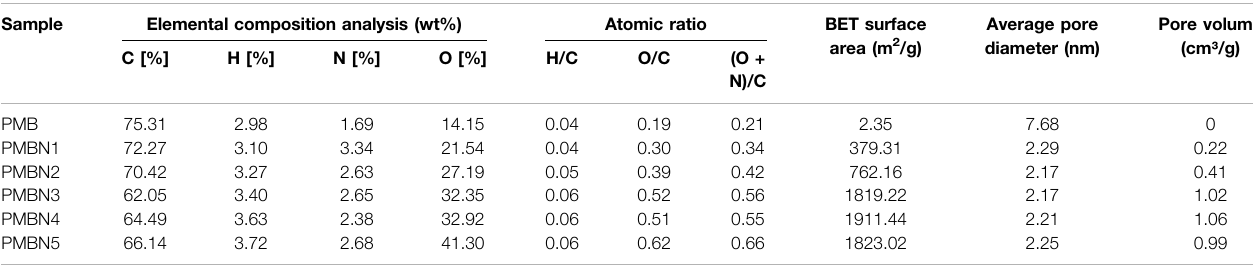
TABLE 1 | The results of elemental analysis and main structural parameters of unmodi fi ed biochar and modi fi ed biochar. Sample Elemental composition analysis